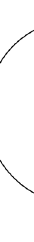
Figure 3. Clamping device was set on the laser machining table.